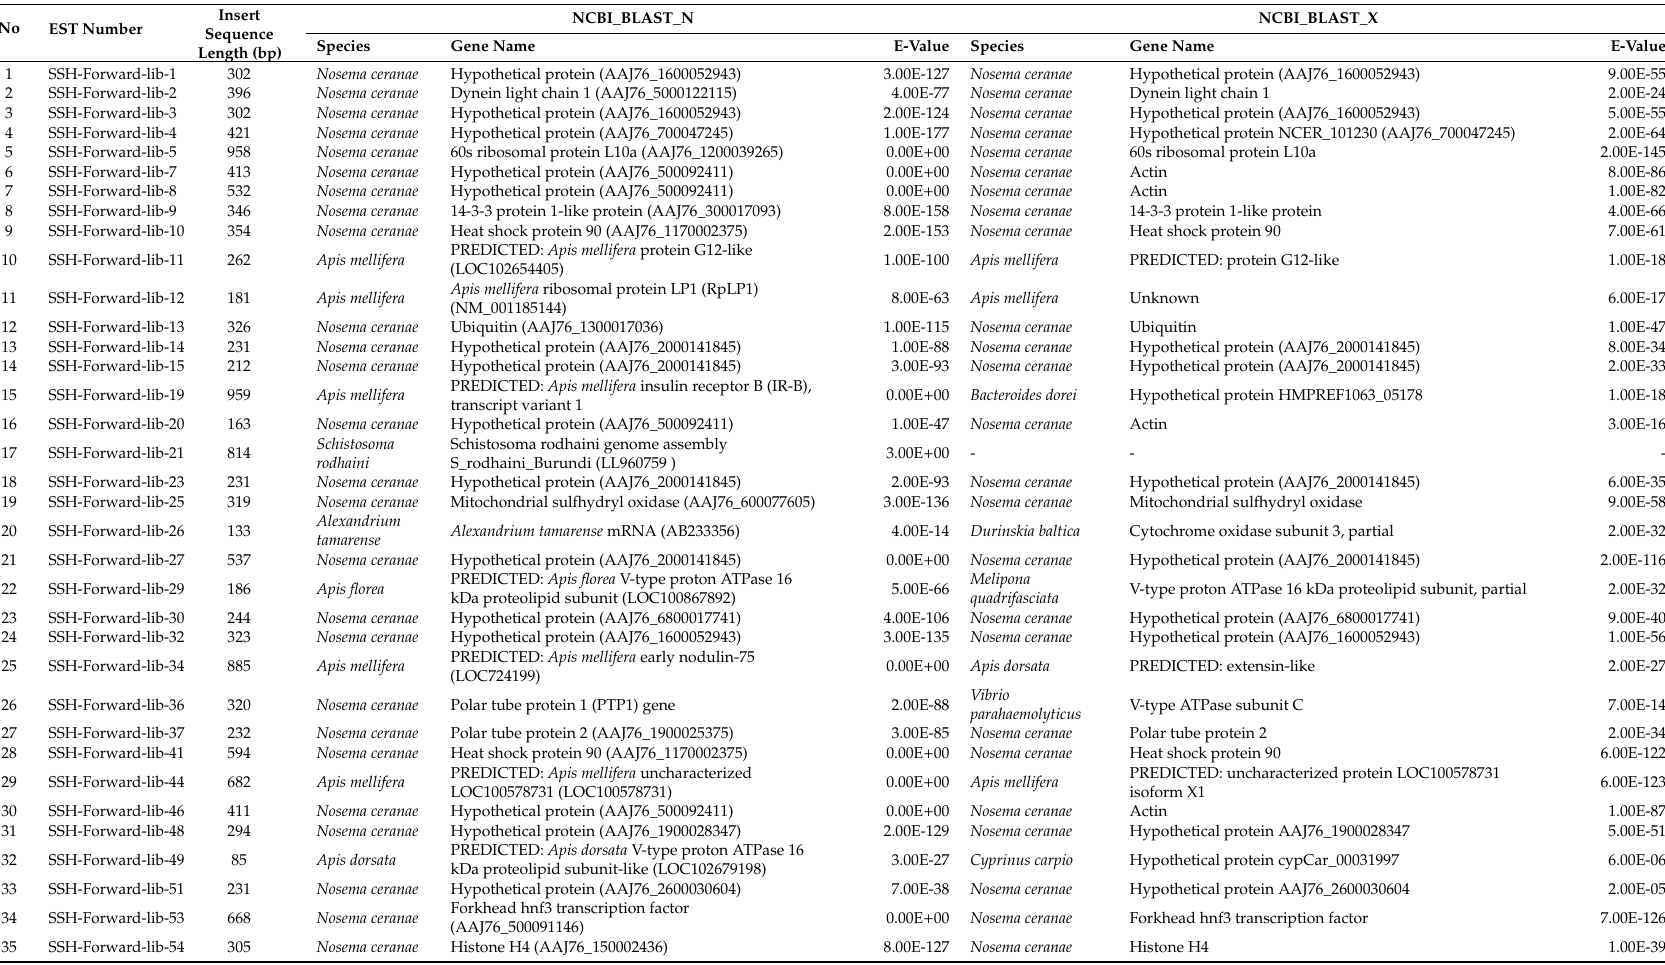
Table 2. Analysis of 65 di ff erential expressed sequence tags (ESTs) identified from forward cDNA library. NCBI = National Center for Biotechnology